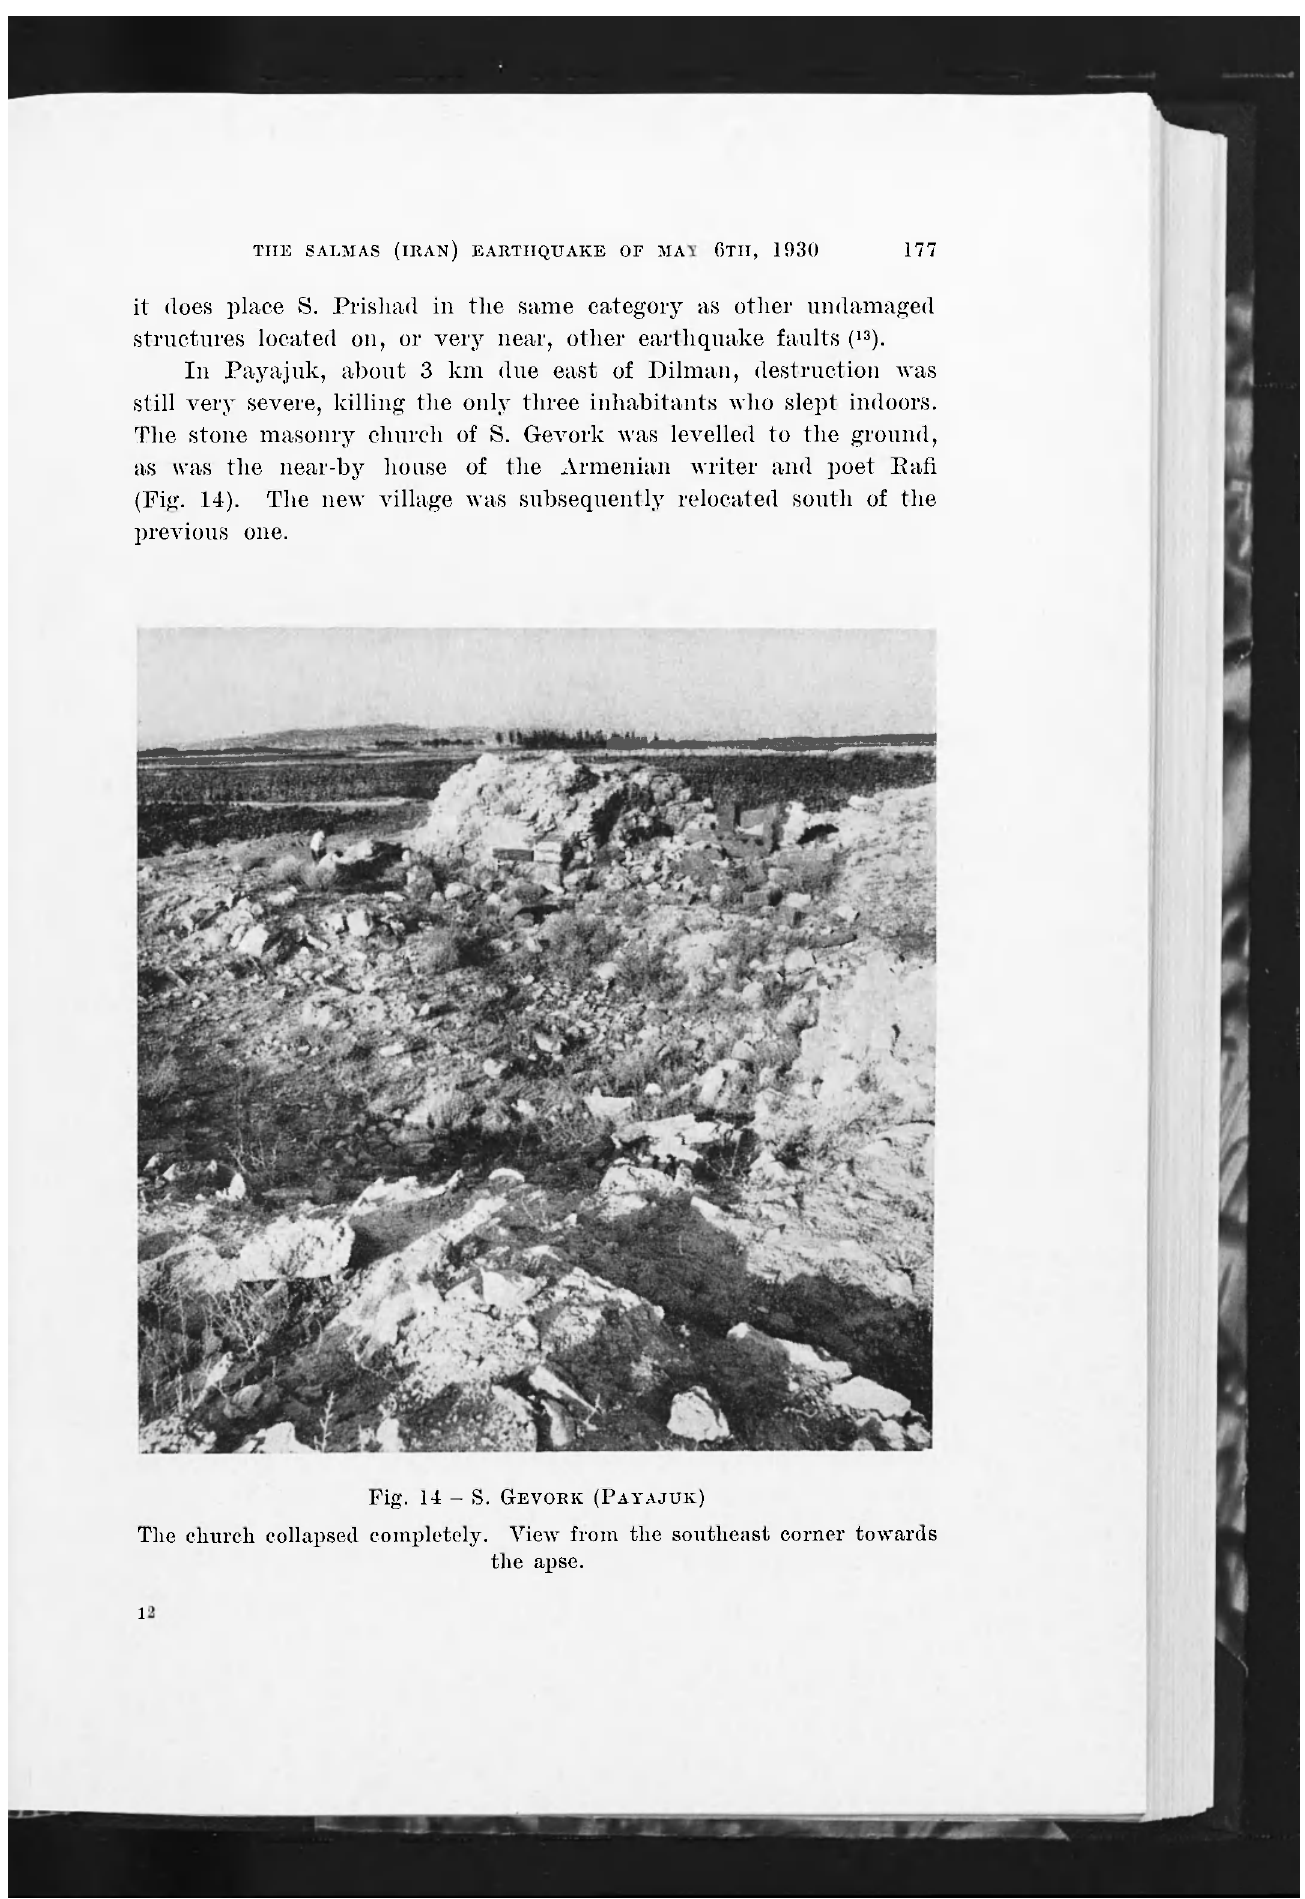
Fig. 14 - S. GEVORK